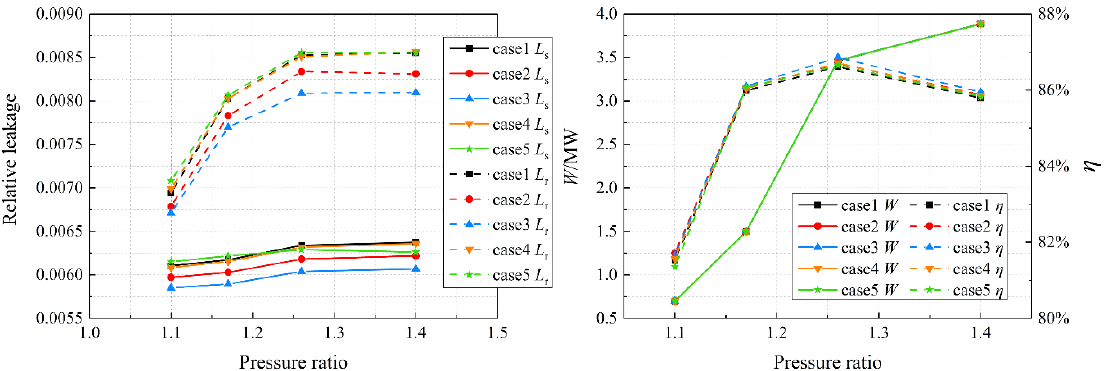
Figure 19. Variations of performance parameters of case1–5 with pressure ratio (left: relative leakage; right: power and efficiency).